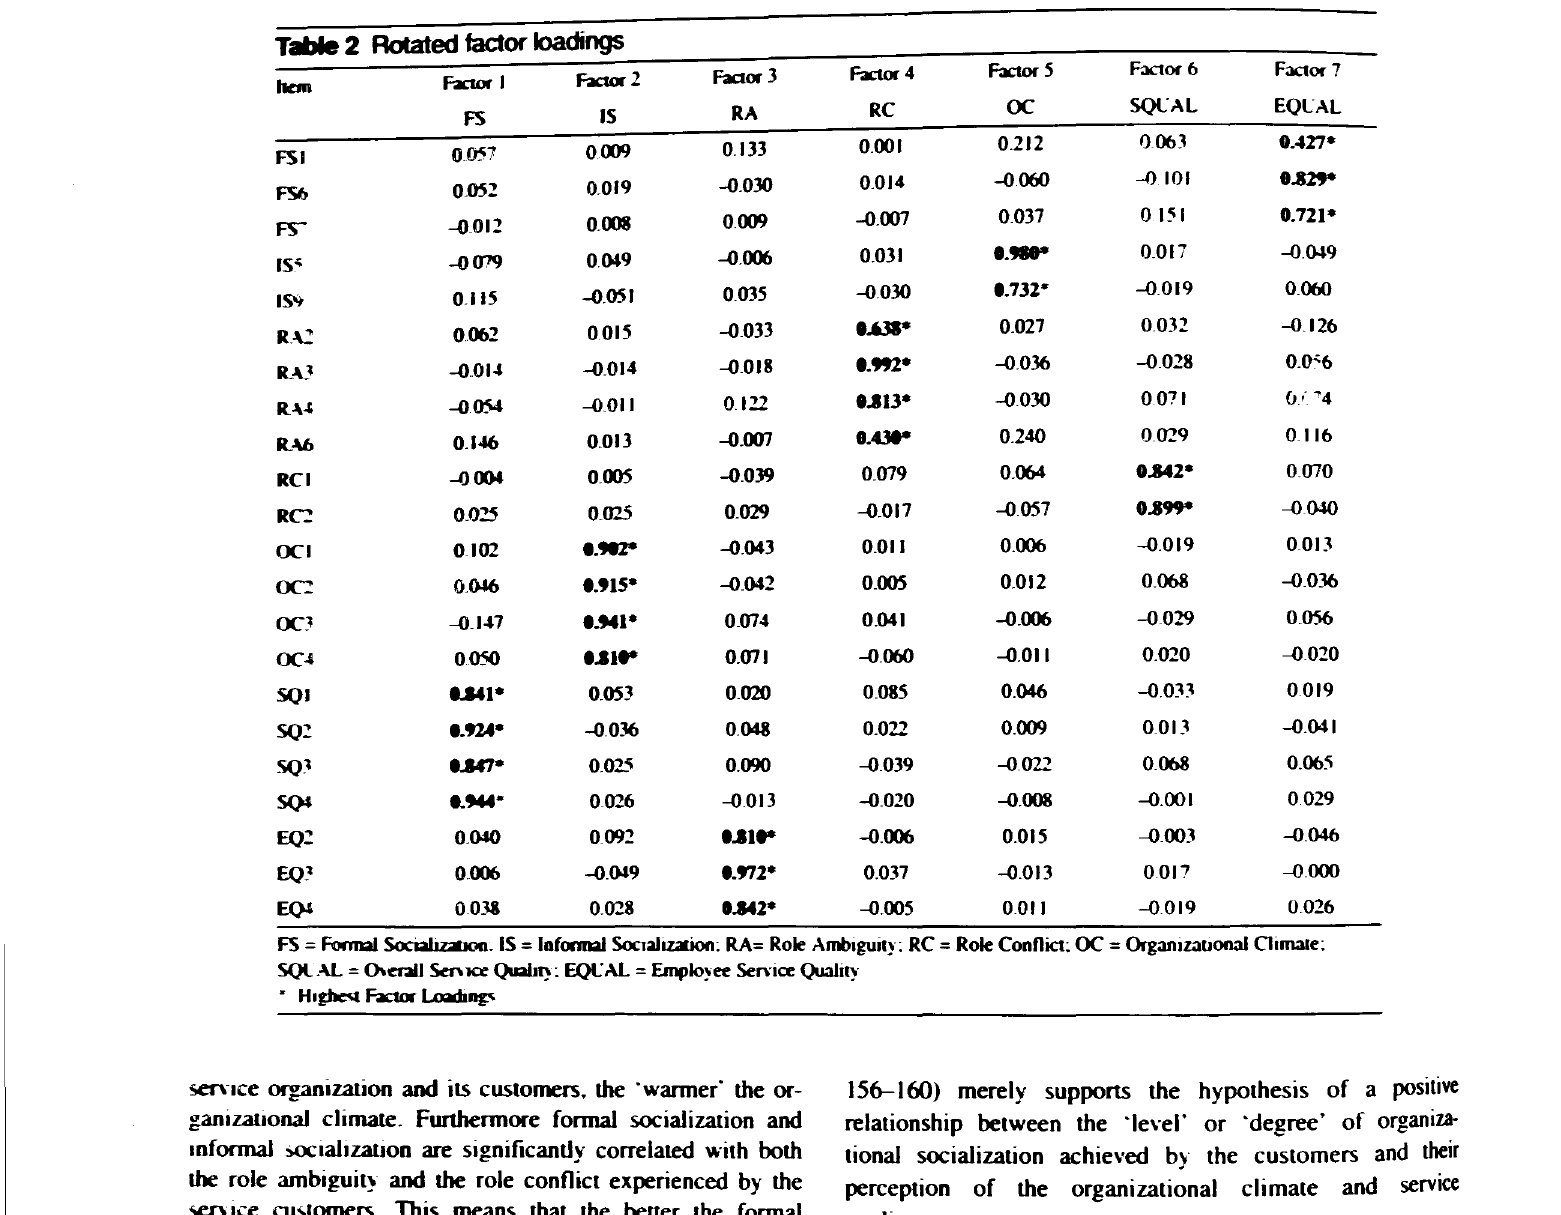
Table 2 Rotated factor